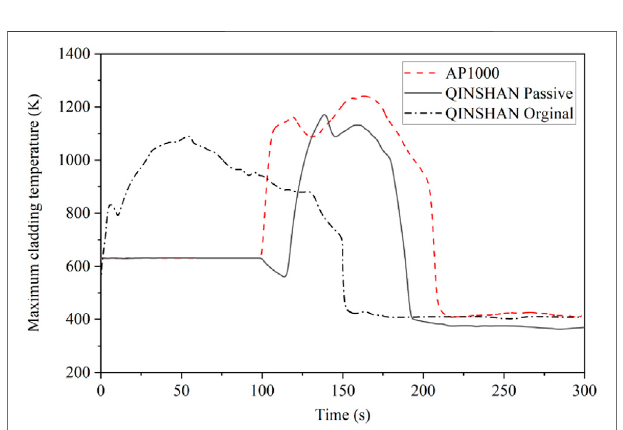
FIGURE 12 | Peak cladding temperature between Qinshan and